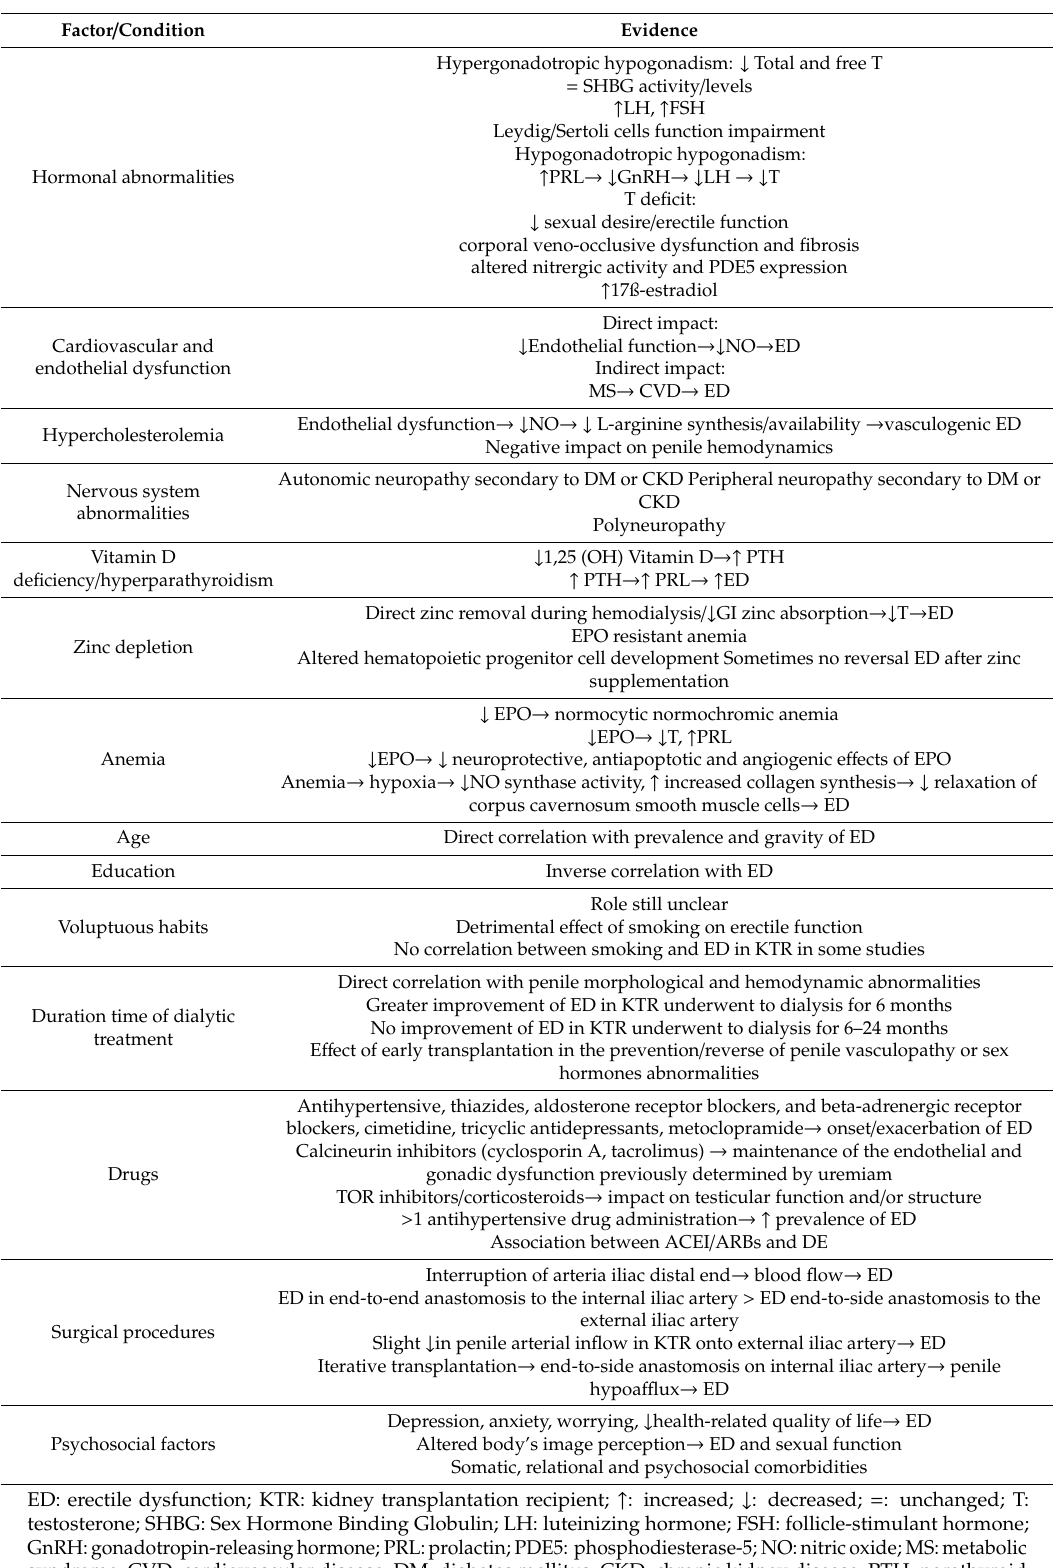
Table 1. Factors and conditions influencing erectile dysfunction (ED) in chronic kidney disease (CKD) / kidney transplantation recipients